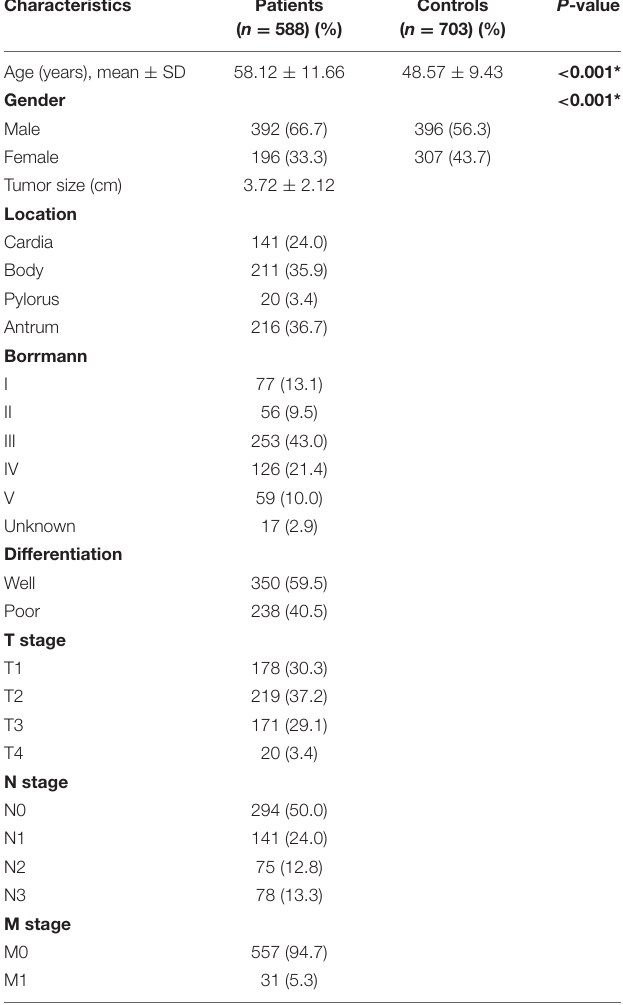
TABLE 1 | Basic demographic characteristics of gastric cancer patients and healthy